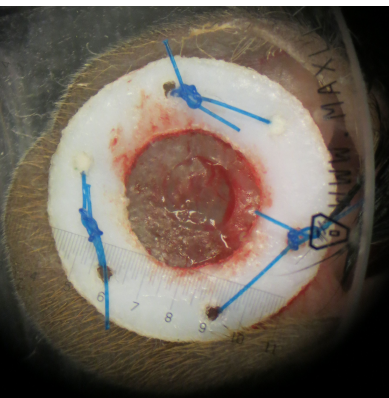
Figure 2. Wound splinting in the mouse ear pinna wound model.